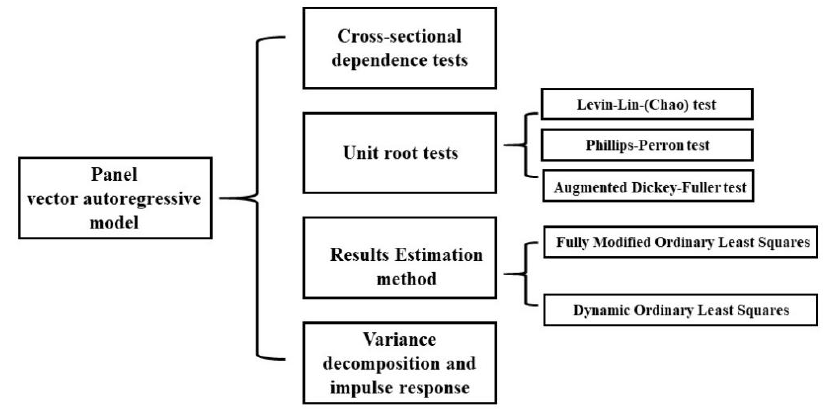
Figure 1. Method flow chart.